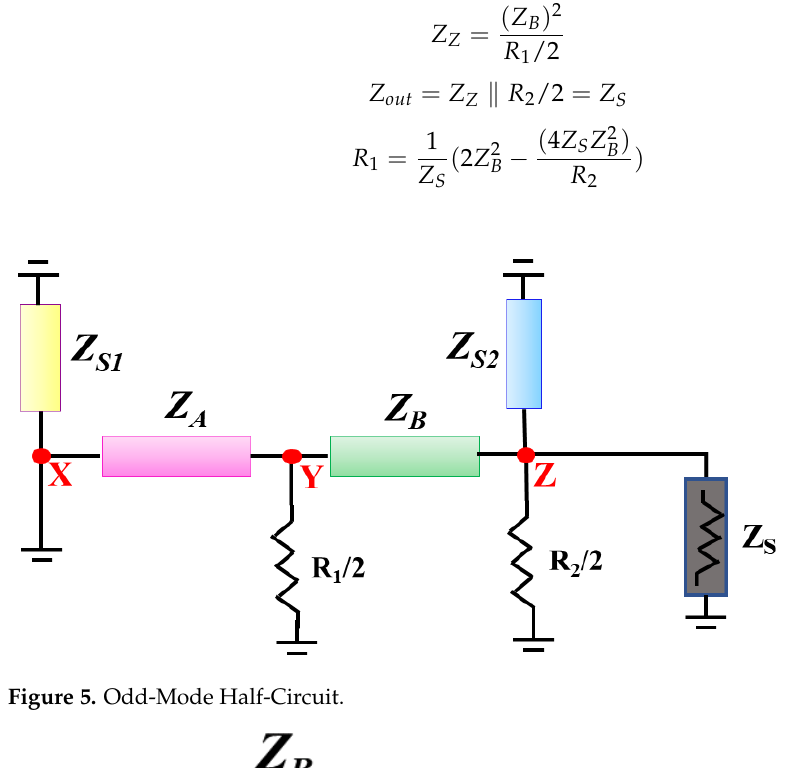
Figure 5. Odd-Mode Half-Circuit.